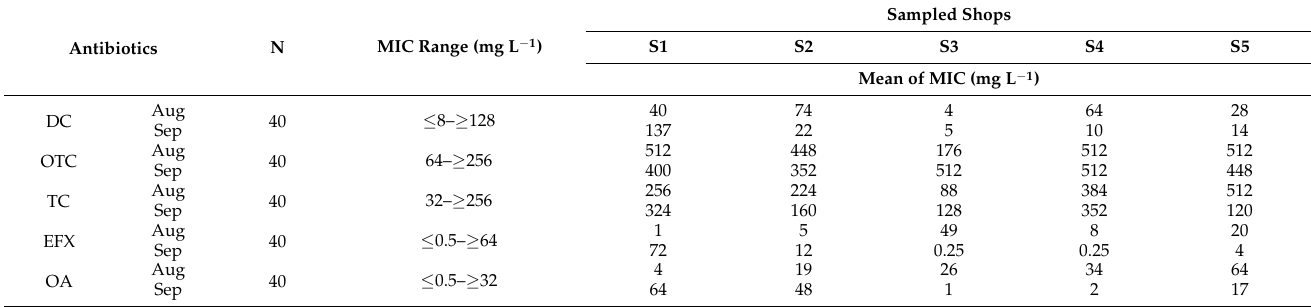
Table 3. Antibiotic resistance prevalence and levels of Pseudomonas